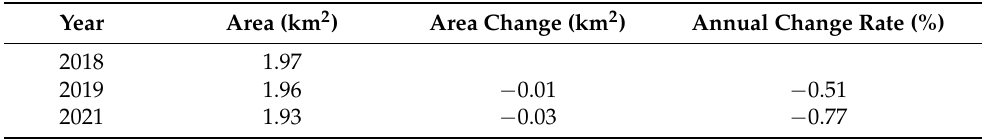
Figure 4. Surface morphology characteristics of LHG12. ( a ) Aspect, on 6 September 2021; ( b ) Roughness, on 6 September 2021; ( c ) Slope, on 6 September 2021; ( d ) Elevation, on 6 September 2021. Table 2. Area changes in the mid–low region of LHG12, 2018–2021. Year Area (km 2 ) Area Change (km 2 ) Annual Change Rate